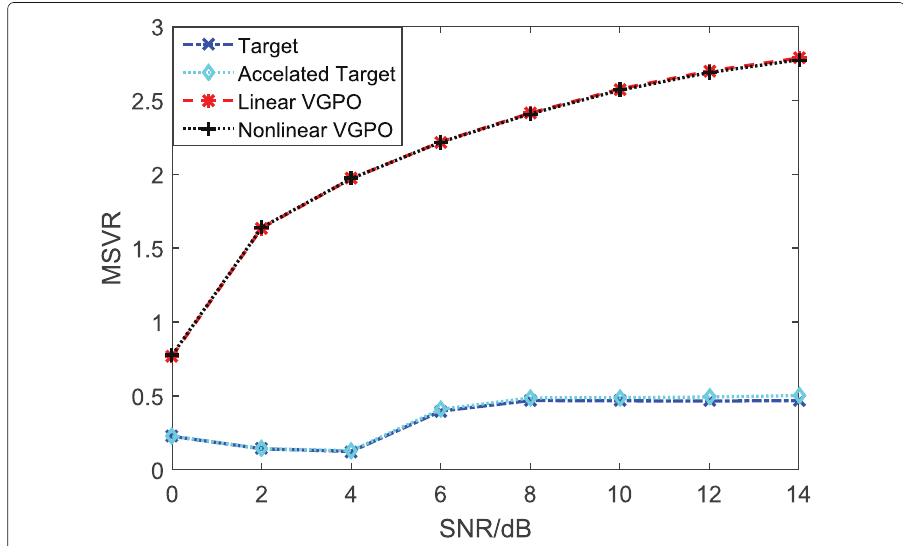
Fig. 6 The MSVR of target echoes and VGPO jamming versus